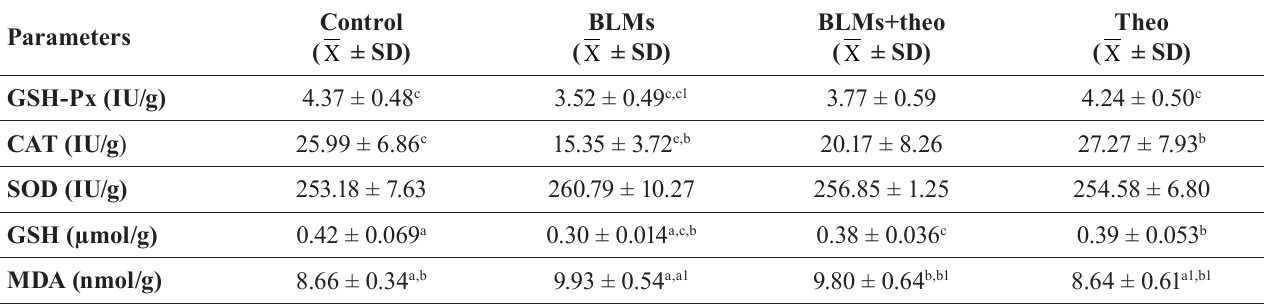
TABLE II - The mean antioxidant enzymes (SOD, CAT and GSH-Px activities), MDA and GSH levels in control, BLMs, BLMs+theo and Theo groups in lung tissue samples